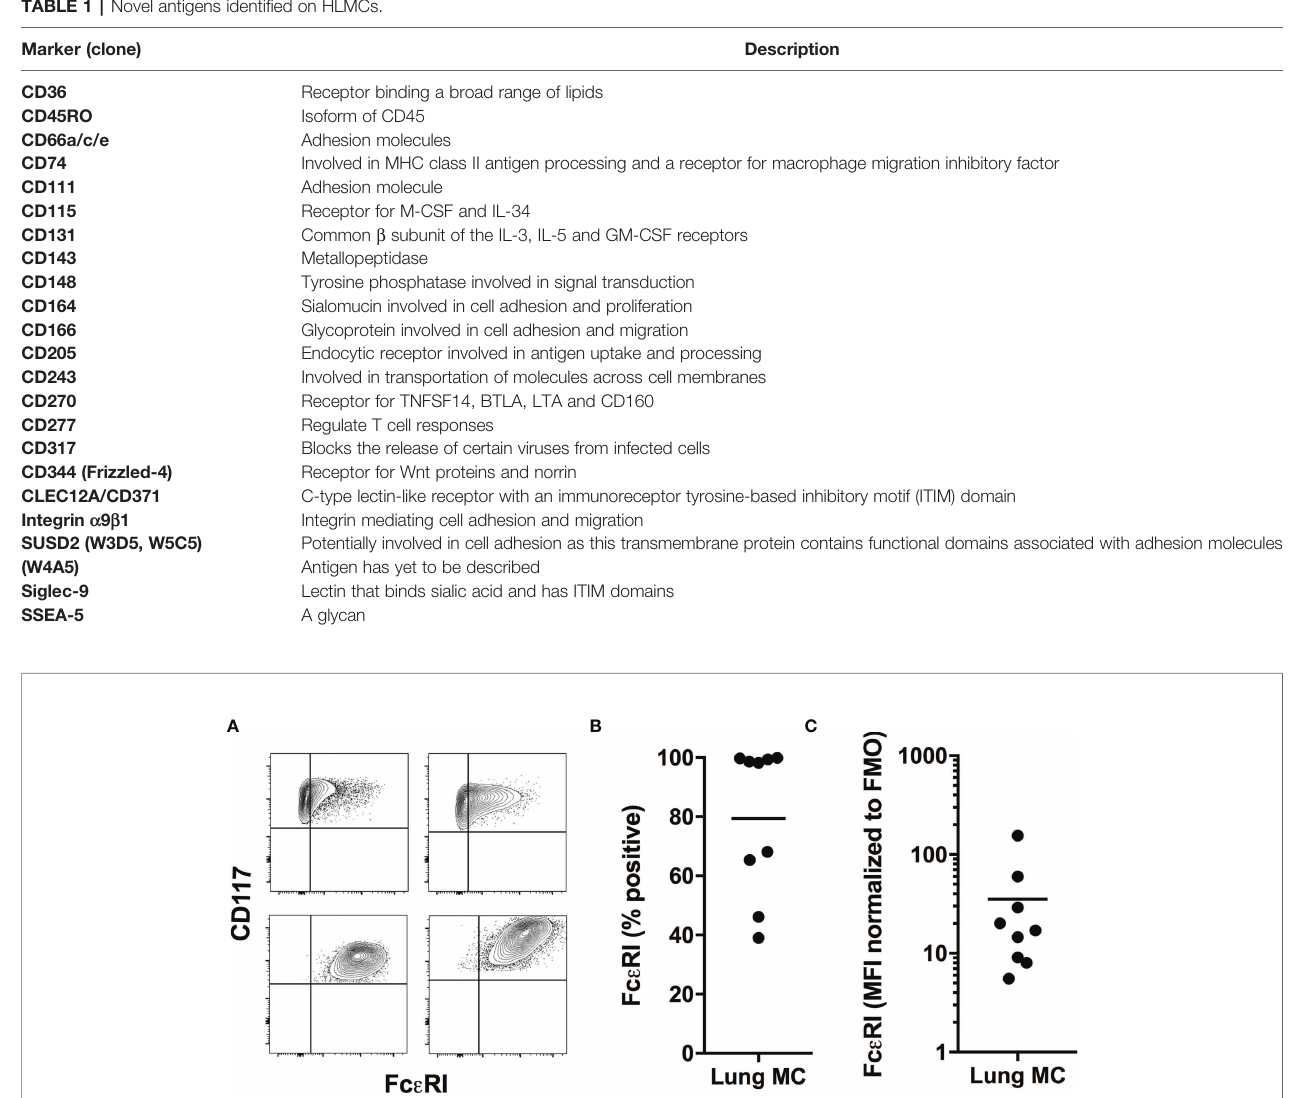
TABLE 1 | Novel antigens identi fi ed on HLMCs.